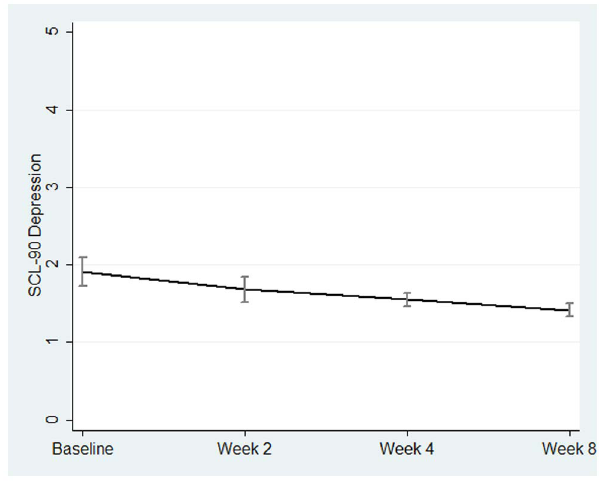
Figure 2. Overtime course of SCl-90 Depression. The line represents the mean score and the error bars represent the standard error at each time point.